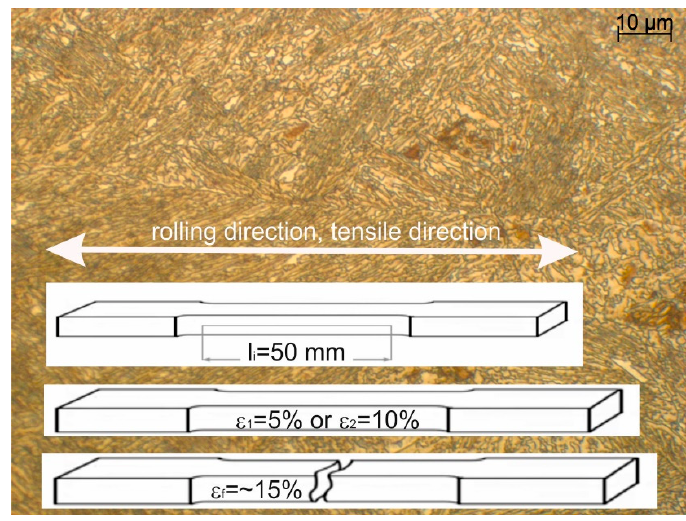
Figure 2. The macroscopic shape of samples used for interrupted tensile tests in respect of the